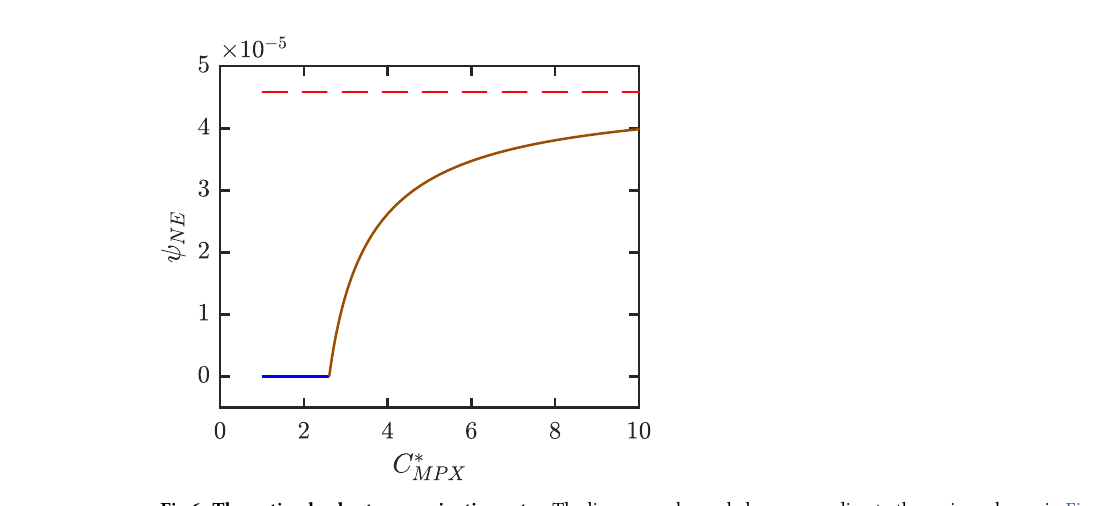
vary. Blue: 0 is MPX